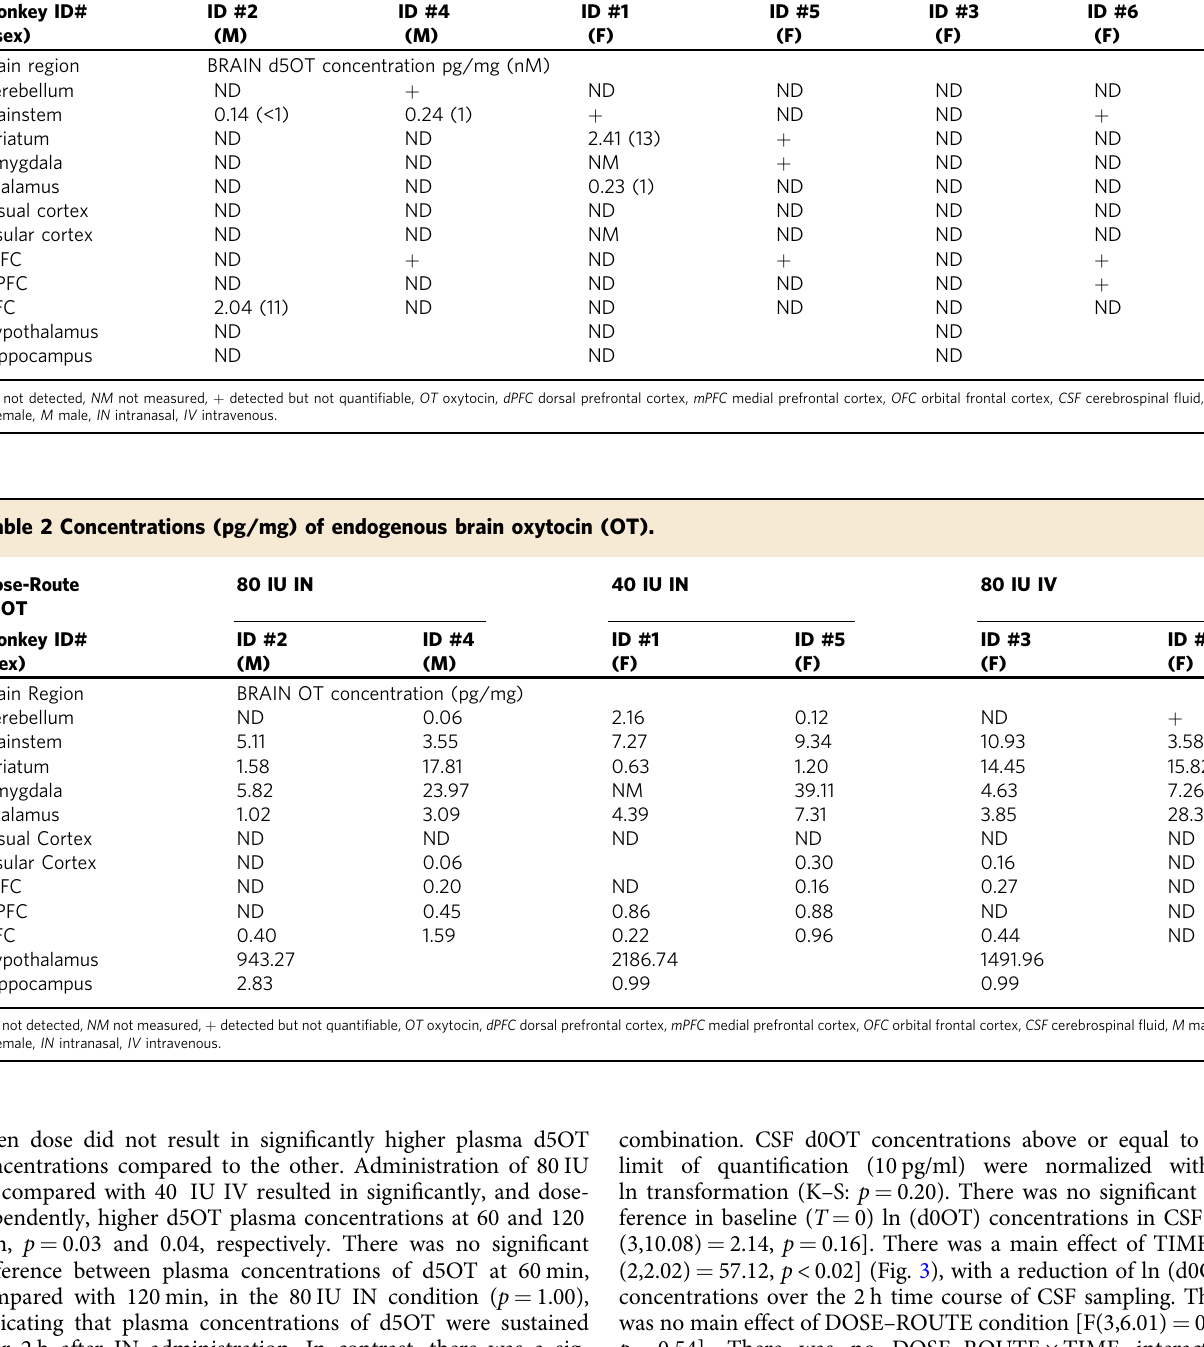
Table 1 Concentrations of administered deuterated oxytocin (d5OT) in the brain of monkeys. Dose – Route